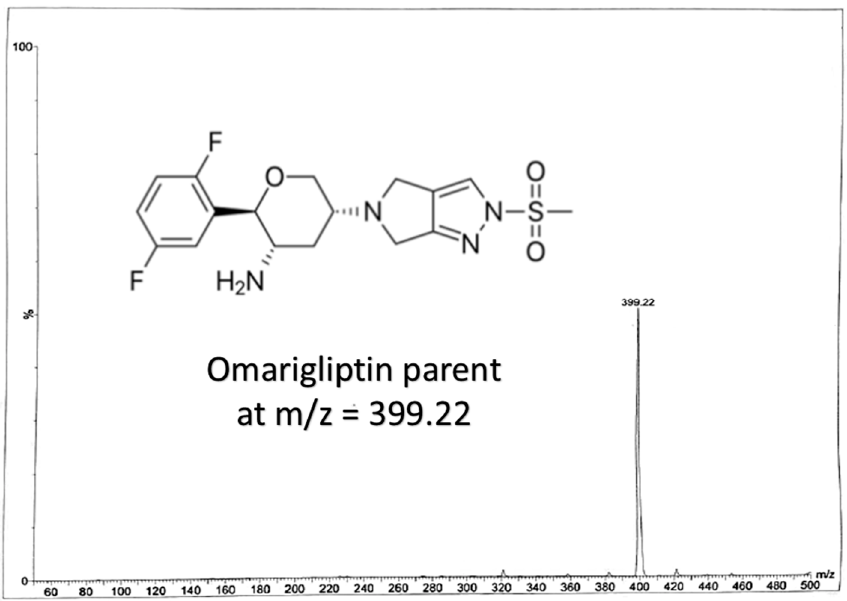
Figure 1. Chemical structure of omarigliptin and its full scan mass spectrum.